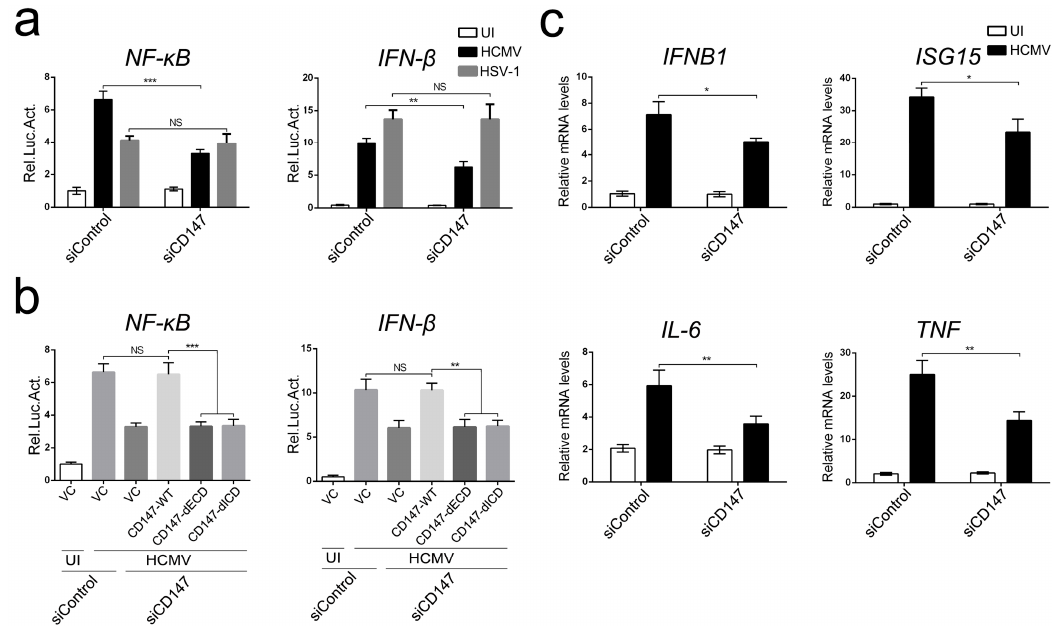
Figure 1. CD147 is involved in Human Cytomegalovirus (HCMV)-triggered early antiviral response. ( a ) Luciferase assay analyzing NF- κ B and IFN- β promoter activity in non-targeting control siRNA (siControl) or CD147-specific short hairpin RNA (siCD147) stable U251 cells (2 × 10 5 ) transfected for 36 h with a plasmid encoding an NF- κ B or IFN- β firefly luciferase reporter (0.1 µ g), along with a Renilla luciferase reporter control plasmid (pRL-TK, 0.01 µ g), then left uninfected (UI) or infected for 6 h with HCMV or HSV-1 (multiplicity of infection (MOI) = 0.5); ( b ) Luciferase assay analyzing NF- κ B and IFN- β promoter activity in siControl or siCD147 stable U251 cells (2 × 10 5 ) transfected for 36 h with a plasmid encoding an NF- κ B or IFN- β firefly luciferase reporter (0.1 µ g) and an expression plasmid for the wildtype CD147 (CD147-WT), or the mutants (CD147-dECD and CD147-dICD) (0.1 µ g), along with a Renilla luciferase reporter control plasmid (pRL-TK, 0.01 µ g), then left uninfected (UI) or infected for 6 h with HCMV before the luciferase assays were performed (MOI = 0.5); and, ( c ) Quantitative real-time polymerase chain reaction (RT-PCR) analysis of IFNB1 , ISG15 , IL-6 and TNF mRNA in siControl or siCD147 stable human foreskin fibroblast (HFF) cells with HCMV uninfected (UI) or infected (MOI = 0.5) for 6 h. The graphical data are presented as the means ± the SDs ( n = 3); NS denotes not significant ( p > 0.05); * denotes p < 0.05, ** denotes p < 0.01 and *** denotes p < 0.001.